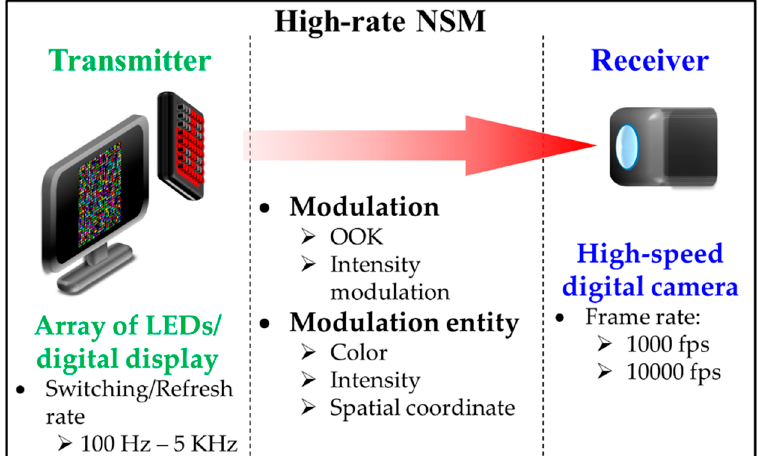
Figure 16. High-rate Nyquist sampling modulation (NSM).